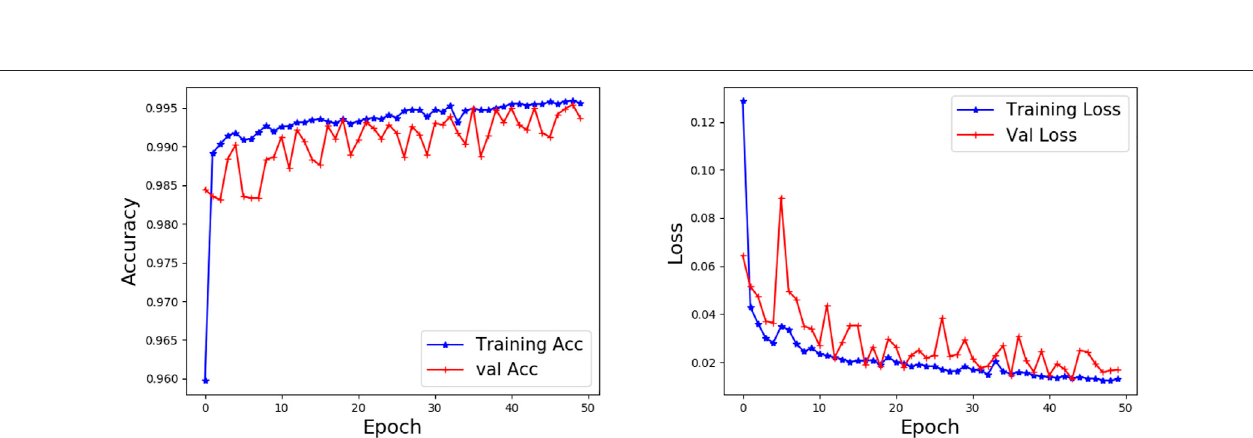
FIGURE 8 | Loss and accuracy performance of the initial model on UNSW-NB 15 datasets.